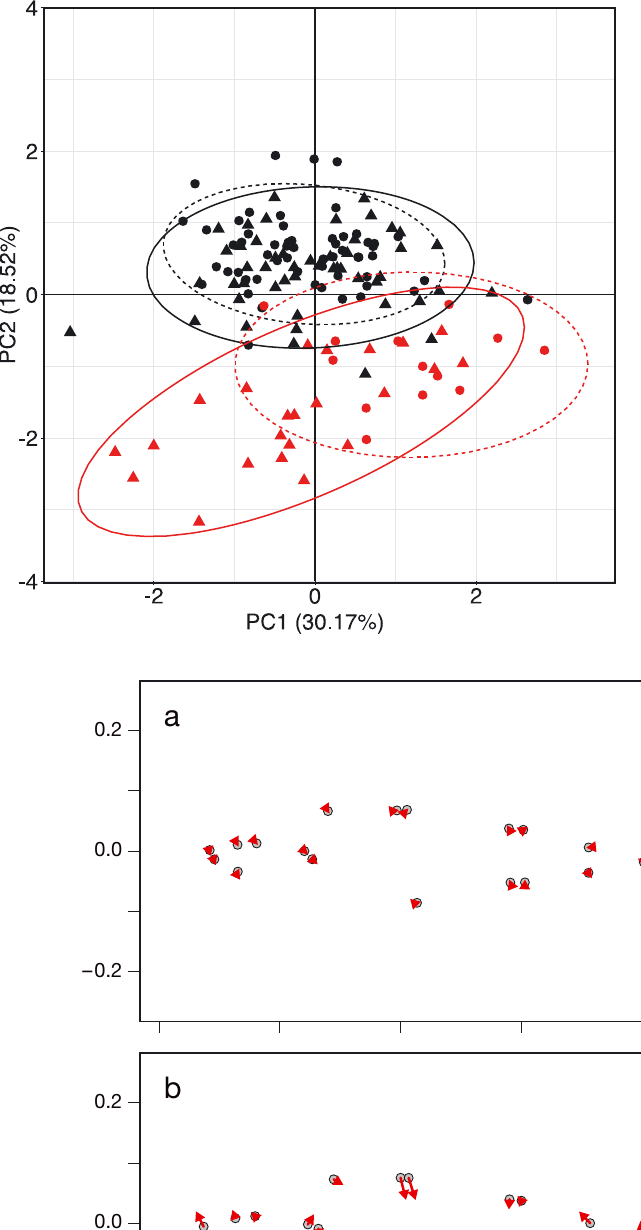
Fig. 4. Ordination plot for configurations of specimens into principal warp space for geometric morphometric analysis of Gadus morhua . Individuals are plotted by origin and sex us- ing colour and shape respectively (farmed = black, wild = red, males = triangles, females = circles; farmed males: n = 58, farmed females: n = 50, wild males: n = 13, wild females: n = 23). Ellipses represent 95% CI for the groups. The same colour scheme is used to denote origins, but sexes are distin- guished by line type (solid = males, dashed = females)